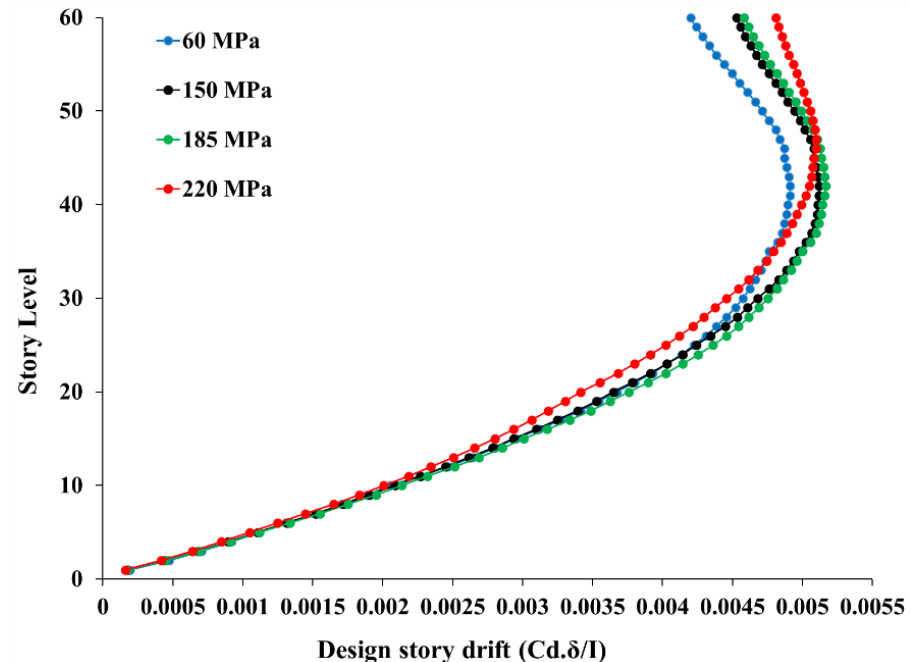
Figure 3. Design story drift.